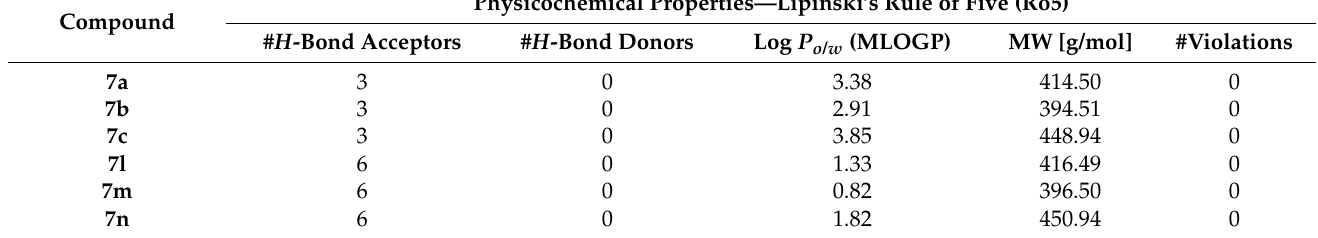
Table 16. Calculated physicochemical properties of investigated derivatives in relation to Lipinski’s rule of five (Ro5) (according to SWISSADME server).